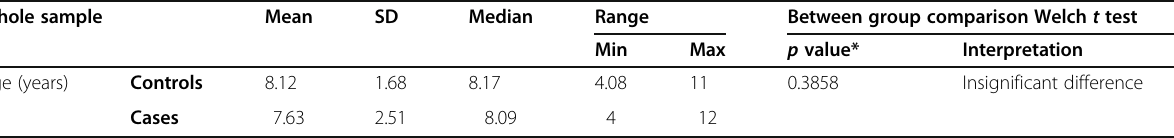
Table 1 Descriptive analysis of age regarding each group and between-group comparisons — N = 60, n controls = 30, n cases = 30 Whole